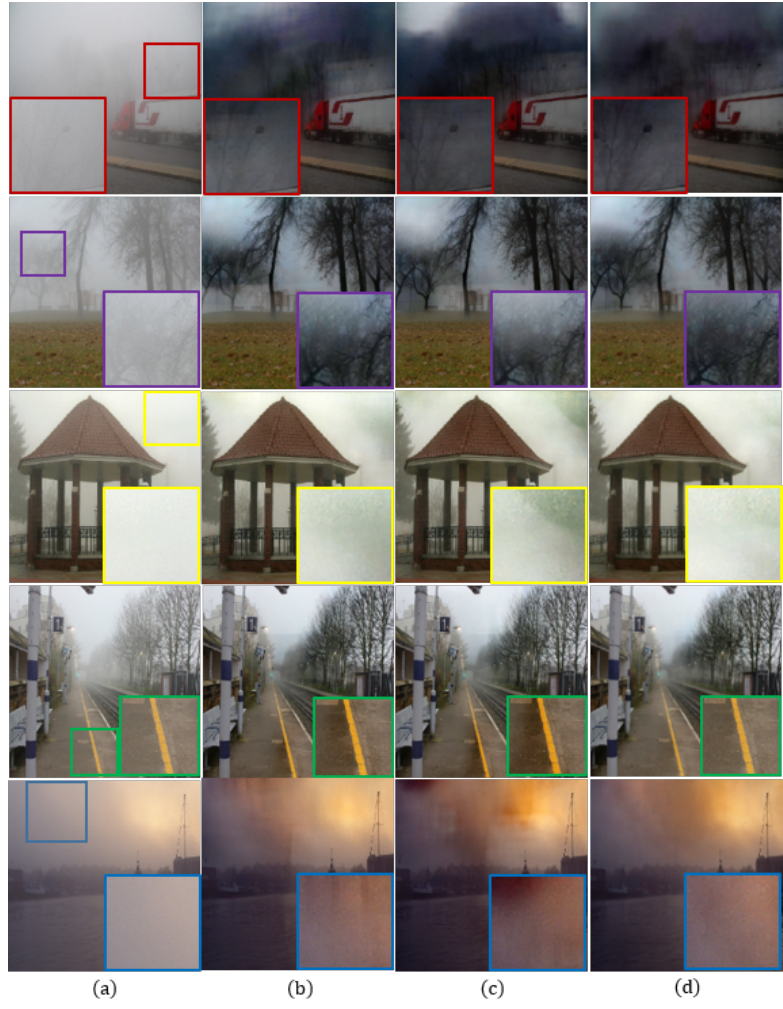
Figure 7. The effect of different loss functions in the proposed model using FADE [36]: ( a ) hazy input + L vgg , and ( d ) the proposed method. image, ( b ) only L l , ( c ) L l 1 1